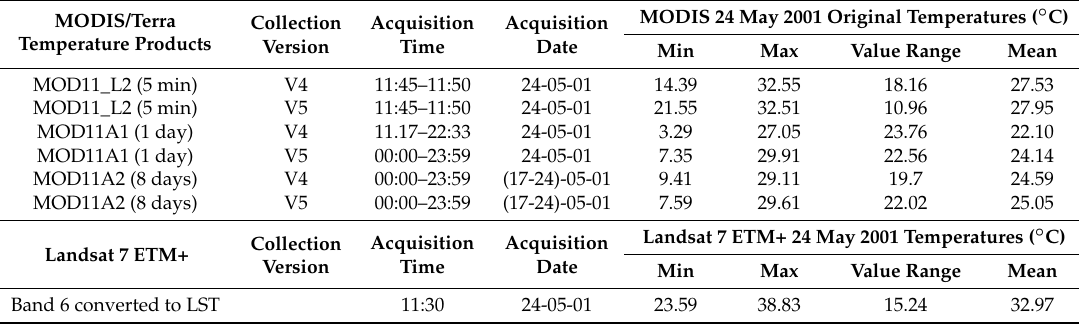
algorithm; (5) the viewing angle dependent generalized split-window method is fully incorporated into the day/night algorithm; (6) no temporal averages in the generation of the 1 km LST product (MOD11A1 and MYD11A1) are made per request of the user community; (7) the surface air temperature (as in V3.0.0 PGE16) is interpolated from the atmospheric temperature profile in MOD07. Table 2. Scene characteristics of LST MODIS/Terra land surface temperature products used for downscaling and the observed Landsat 7 ETM+ land surface temperature (Band 6–low gain). Data calculated at 960 m resolution with 99% of the value